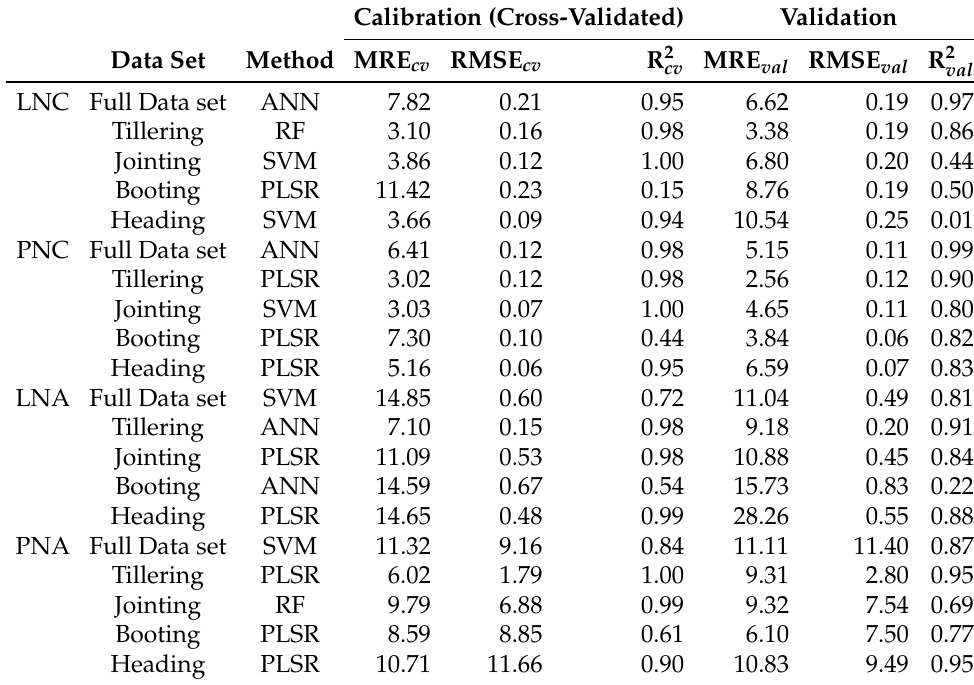
Table 4. The goodness-of-fit values of the best-performing models of the full-growth-stage and each growth-stage-specific models for LNC, PNC, LNA and PNA selected by MRE cv . Calibration